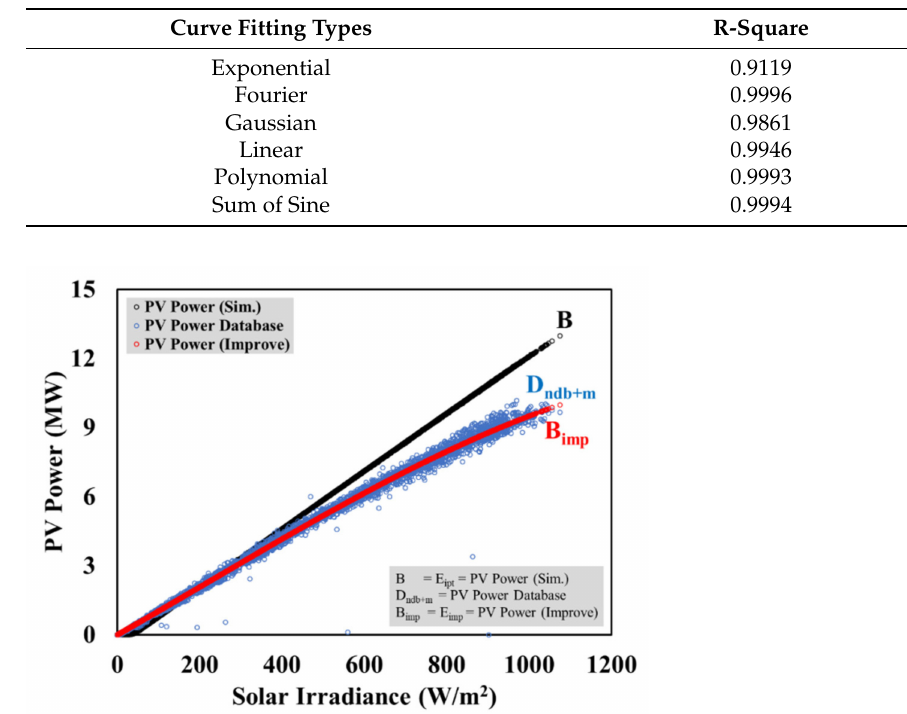
Table 4. R-square values of the curve-fitting types.